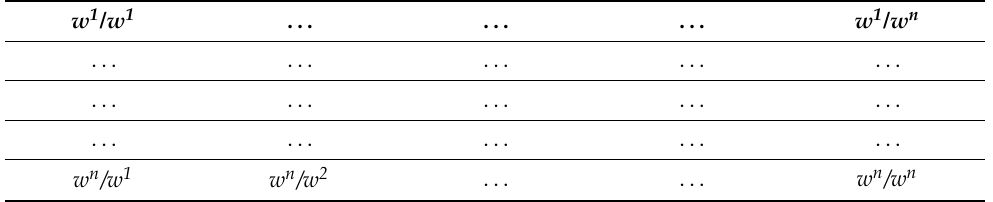
Table 3. The structure of a (n × n) perfectly consistent PCM.